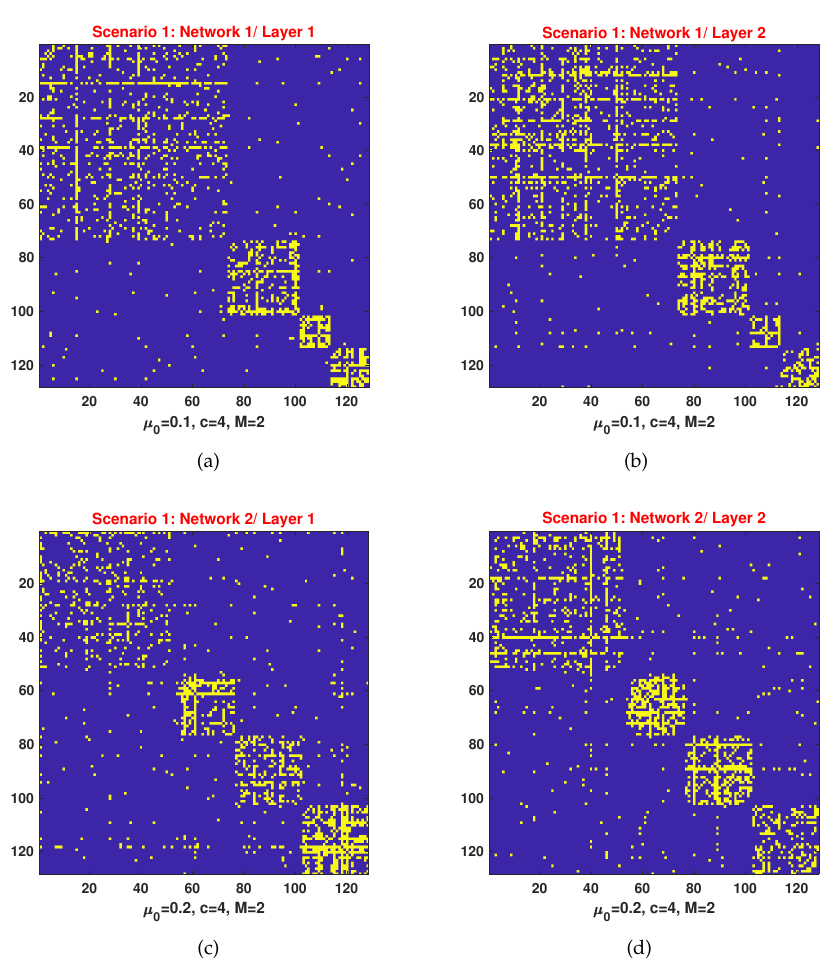
Figure 2. Examples showing some of the simulated 2-layer multiplex networks generated with n = 128, c = 4 and variable µ 0 . ( a , b ) Adjacency matrices with µ 0 = 0.1; ( c , d ) Adjacency matrices with µ 0 =